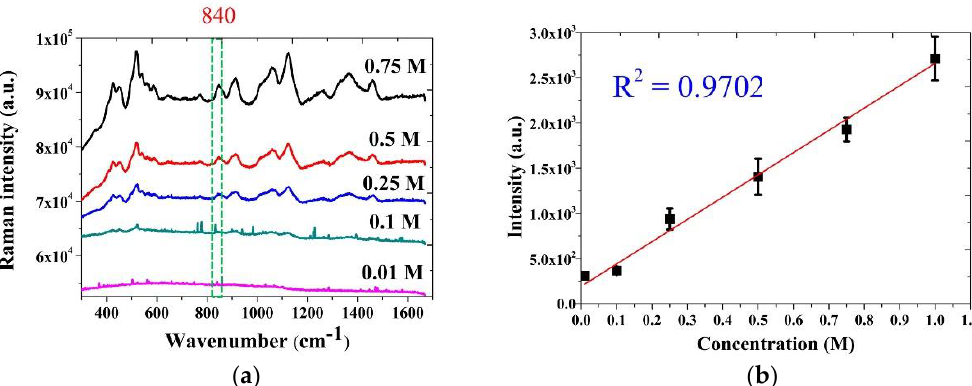
Figure 7. ( a ) The intensity of the Raman signals of different glucose concentrations on the NPS-AuFON. ( b ) The relationship between the Raman intensity and glucose concentration.